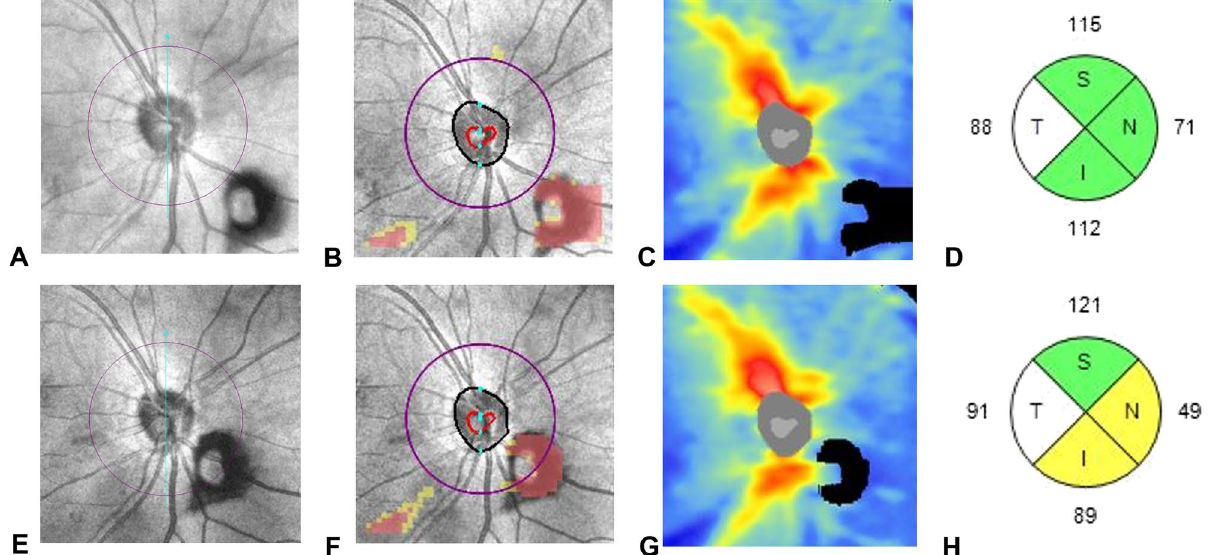
Figure 3. A representative SD-OCT scan (optic disc cube: 200 × 200) for group W eyes. A 64-year-old male patient presented with a right eye symptomatic floater. On dilated fundus examination, a Weiss ring was observed near the optic disc, without any peripheral retinal break ( A – D ). OCT fundus image showing a Weiss ring in the inferonasal area of the optic disc ( A ). In the deviation map, a red cluster is observed outside the 3.46-mm-diameter scan circle (purple circle) from the center of the optic disc, in the same location as the Weiss ring in the OCT fundus image ( B ). In the thickness map, a black defect is observed in the same location as the Weiss ring in the OCT fundus image ( C ). Quadrant map showing the pRNFL thickness. After 4 months, the follow-up SD-OCT image showed a Weiss ring within the scan circle ( E – G ). Quadrant map showing reduced inferior and nasal pRNFL thicknesses compared to the previous map ( H